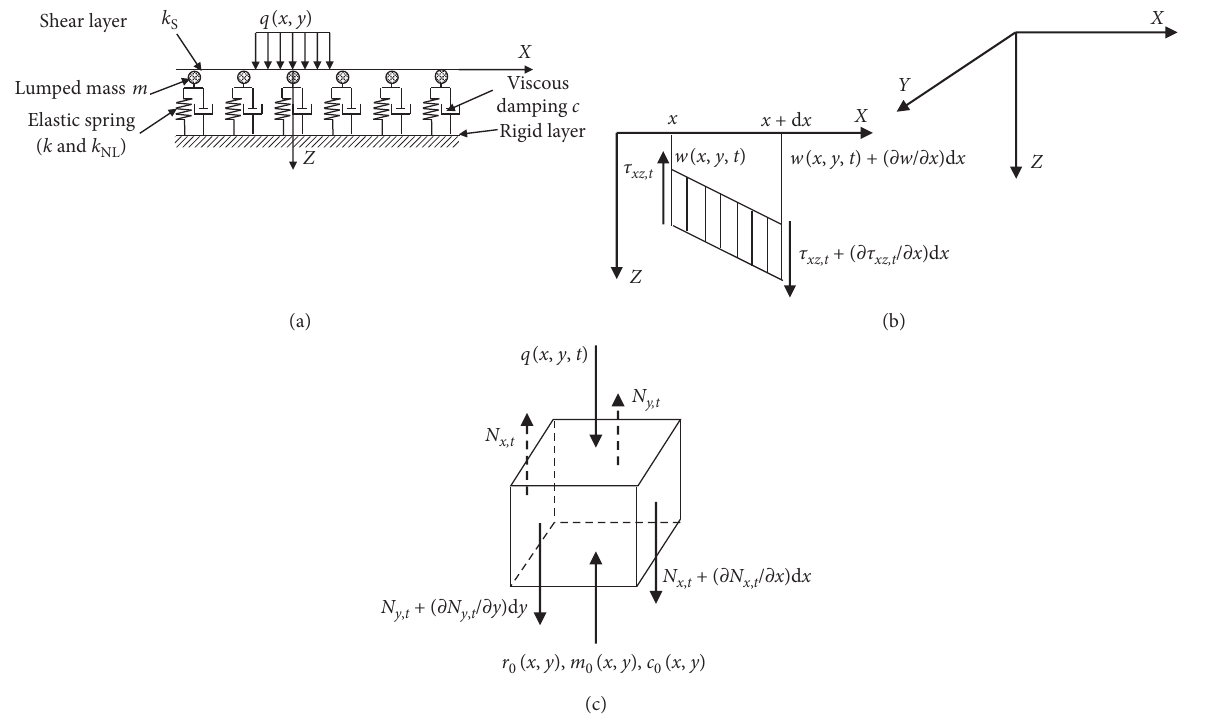
Figure 2: The nonlinear dynamic foundation model: (a) basic foundation model, (b) stress in the shear layer, and (c) acting forces on the shear